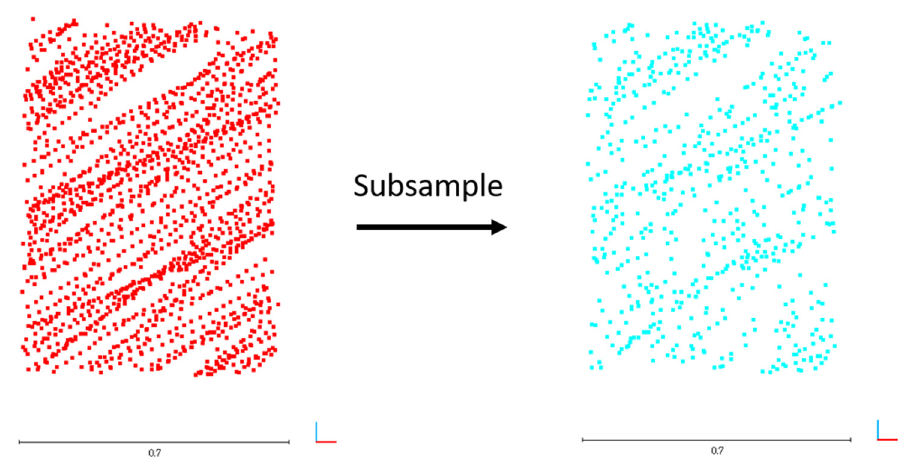
Figure 16. The illustration of subsampling results in plane K. Table 8. The statistics of calculated ranging measurement in each plane after subsampling and blunder removal by the RANSAC algorithm for dataset DATA2.